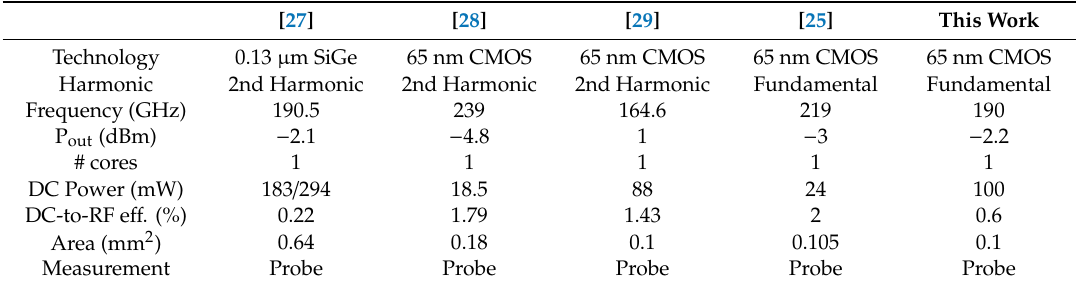
Table 1. Performance comparison with state-of-the-art mm-wave